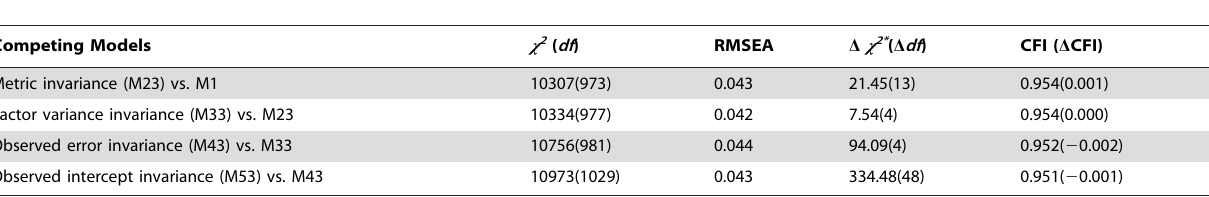
Table 7. Longitudinal measurement invariance tests of demand-control-support factor model across 2010 & 2012.